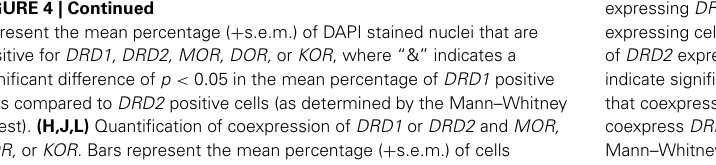
expressing DRD1 also expressing DRD2 , the percentage of DRD1 expressing cells also expressing MOR, DOR, or KOR and the percentage of DRD2 expressing cells also expressing MOR, DOR, or KOR , where “ ∗ ” indicate significant differences of p ≤ 0 . 05 in the percentage of cells that coexpress DRD1 and MOR, DOR or KOR compared to cells that coexpress DRD2 and MOR, DOR, or KOR (as determined by the Mann–Whitney U